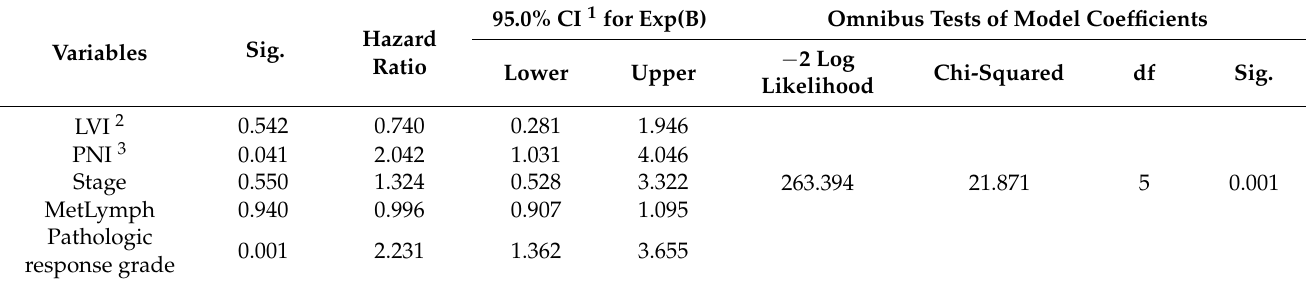
Table 3. Multivariate analysis of factors that affect survival.